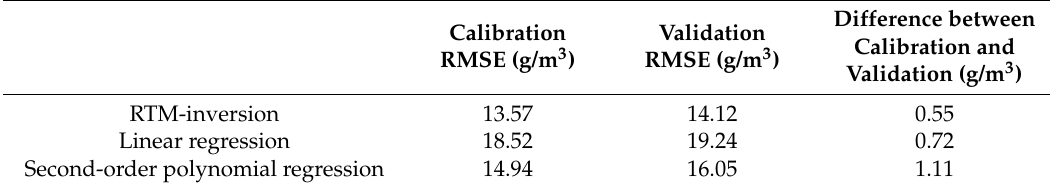
Table 4. Root-mean-square-error (RMSE) estimated using multispectral data with the “Red” spectral band (centered around 650